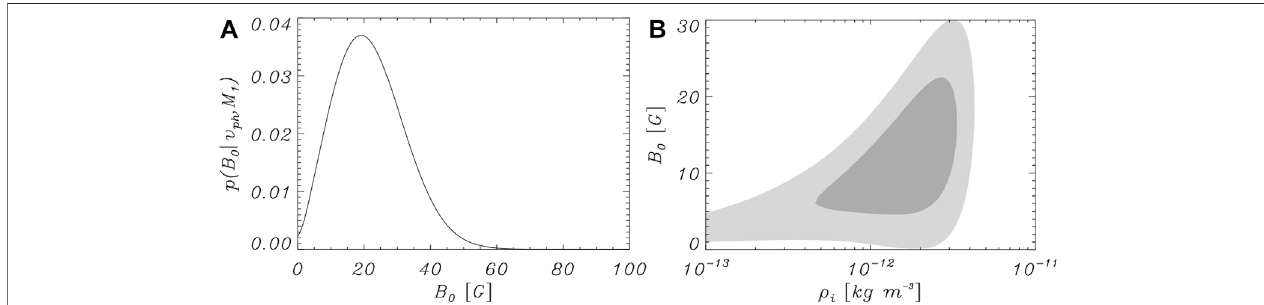
FIGURE 2 | (A) Posterior probability distribution for the magnetic fi eld strength for a loop oscillation event with observed phase speed v ph = 1,030 ± 410 km s − 1 under model M 1 , given by Eq. 6 . The inferred median value for the magnetic fi eld strength is B 0 (cid:2) 21 + 12 − 9 G, with uncertainties given at the 68% credible interval. (B) Joint two-dimensional posterior distribution for the internal density of the waveguide and the magnetic fi eld strength obtained for the inference with a Gaussian prior for